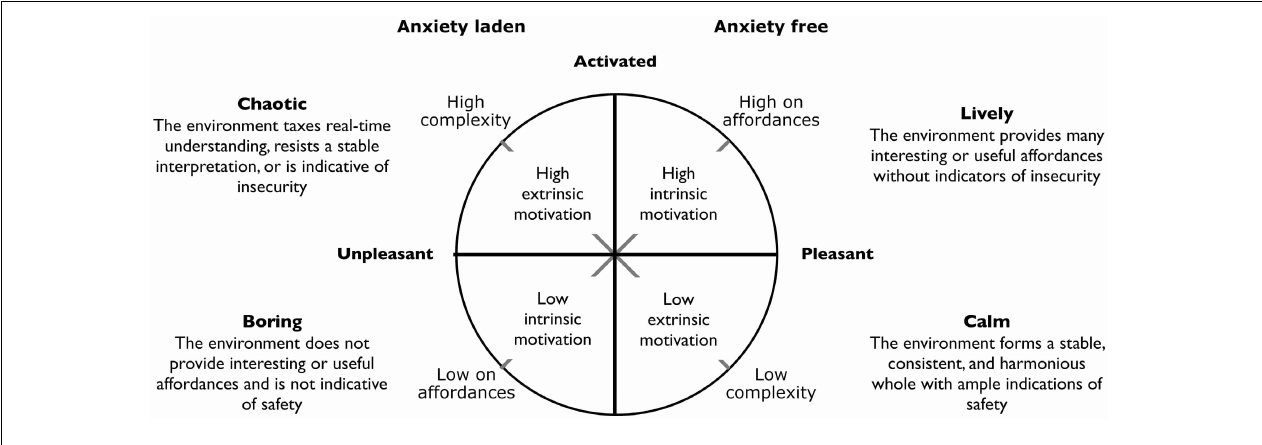
FIGURE 3 | Core affect, appraisal, and four affective states estimated from soundscape research (Andringa, 2013). The main axes reflect the dimensions of core affect, the descriptions in the corners reflect typical